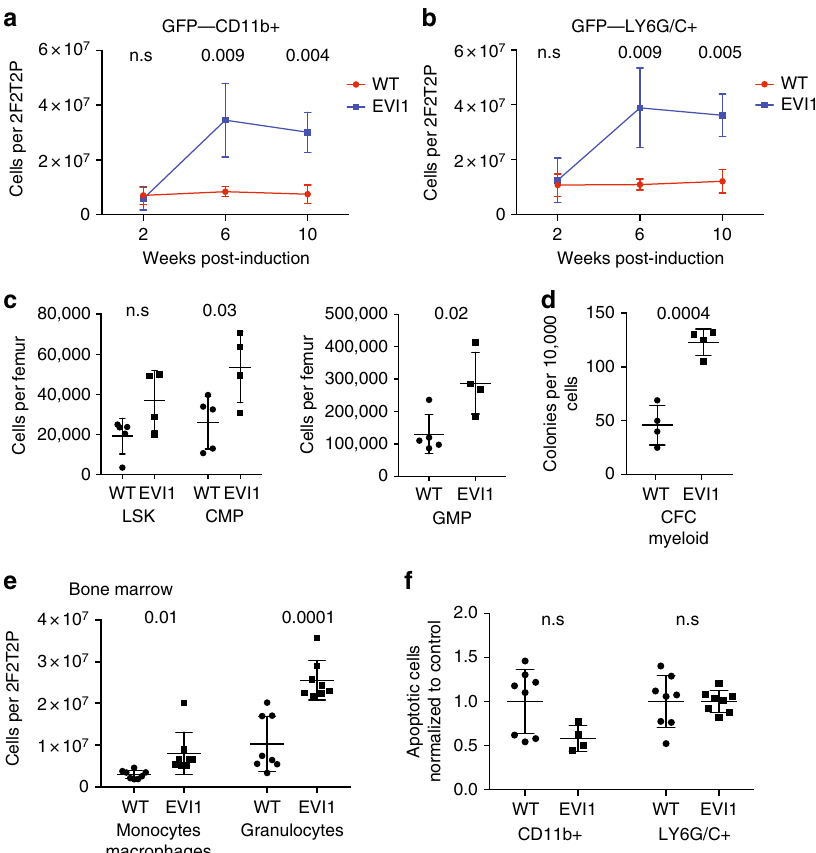
Fig. 4 EVI1 overexpression expands myelopoiesis. a Quanti fi cation of GFP − , CD11b + myelocytes, either overexpressing EVI1 or WT as indicated in WBM of competitively transplanted recipients, harvested 2, 6, or 10 weeks after DOX induction. (WT n = 4 mice, EVI1 n = 4 mice at each time point, total n = 24). b Quanti fi cation of GFP − LY6G/C + myelocytes, either overexpressing EVI1 or WT in WBM of competitively transplanted recipients harvested 2, 6, or 10 weeks after DOX induction. (WT n = 4 mice, EVI1 n = 4 mice at each time point, total n = 24). c Flow cytometry analysis of progenitor populations from recipient mice after 10 weeks of DOX treatment. Data represents mean number of cells per femur for individual mice. (WT n = 5, Evi1 + n = 4). d Relative numbers of GFP − CFC-myeloid (G − , M and GM-CFC) in bone marrow of competitively transplanted mice 10 weeks post induction,